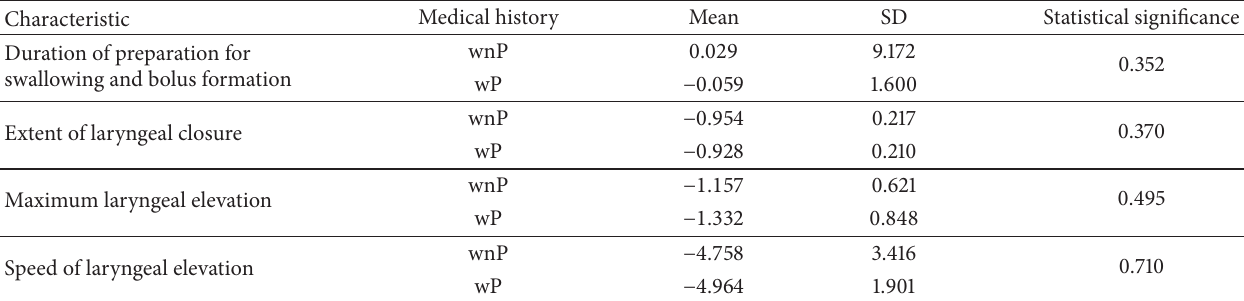
Table 4: Patient swallowing